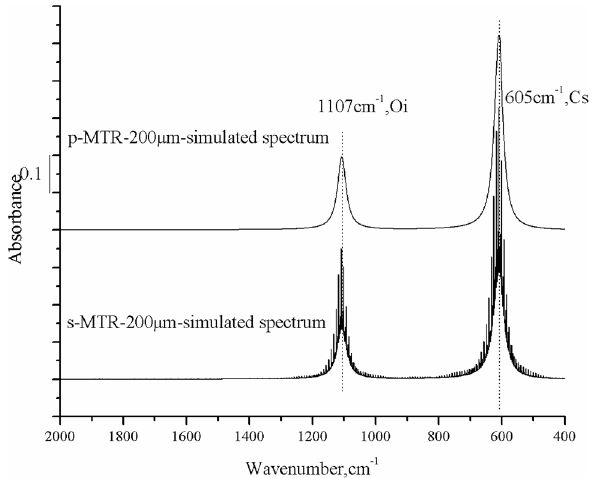
Figure 7. Simulated infrared spectra of substitutional carbon and interstitial oxygen in a thin silicon wafer 200 μm thick using p- and s-polarized light at the Brewster incidence angle. The parameters for calculation are b = 0.02 cm, incidence angle = 74°, N = 8, R s = 0.71, and R p = 0. The image was created using Origin 2017 (simplified Chinese), http://www.32r.com/soft/16769 .html.